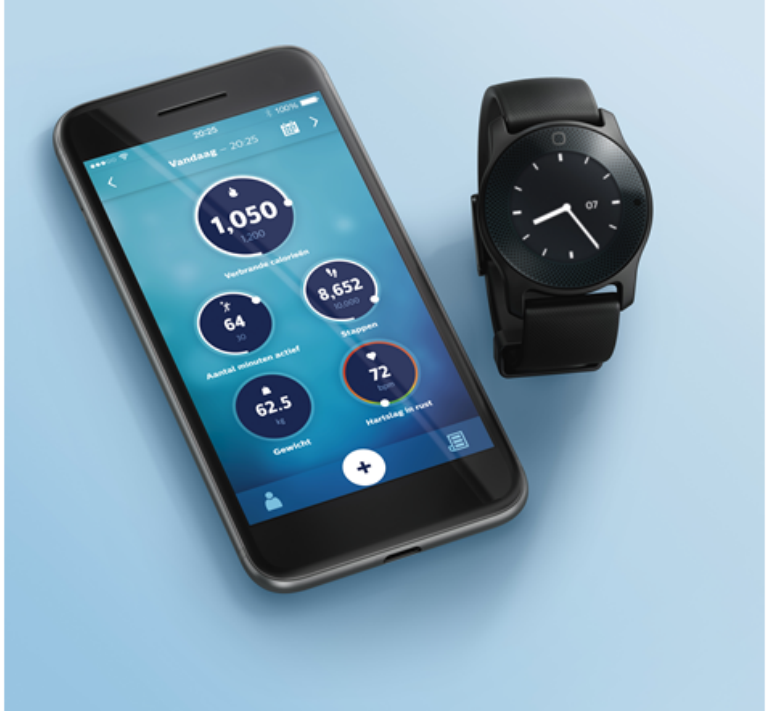
Figure 1. The Philips health watch with companion app running on a mobile